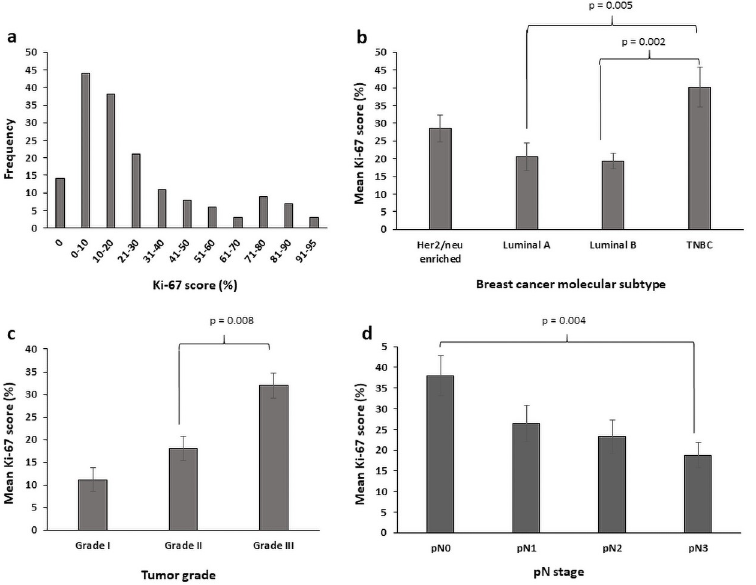
Fig 2. Distribution of Ki-67 expression in breast cancer cases. (a) Number of cases in each group with different Ki- 67 scores. (b) Mean Ki-67 scores in different breast cancer molecular subtypes. (c) Mean Ki-67 scores in breast cancer cases of different grades. (d) Mean Ki-67 scores in breast cancer cases of different pN stages. TNBC, triple negative breast cancer. Tukey’s post hoc multiple comparisons test was performed to identify significant differences between breast cancer